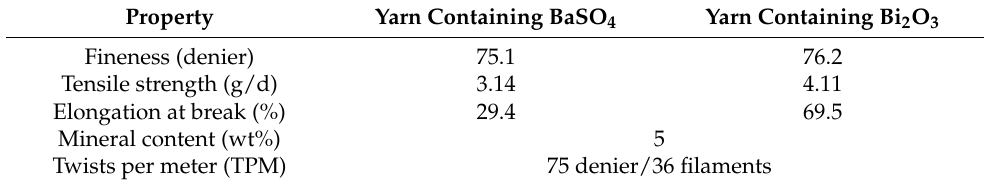
Table 2. Physical properties of shielding fiber yarns.